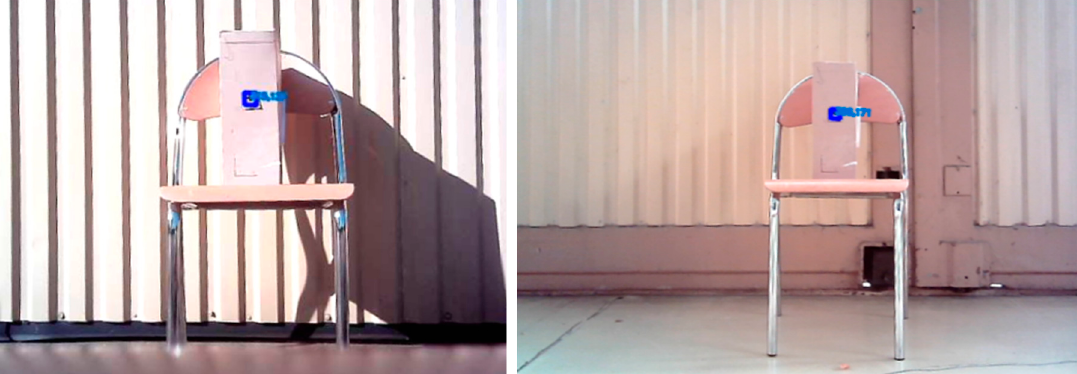
Figure 3. The marker identification rate versus distance. Table 1. Measurement results at 770 lx light intensity.